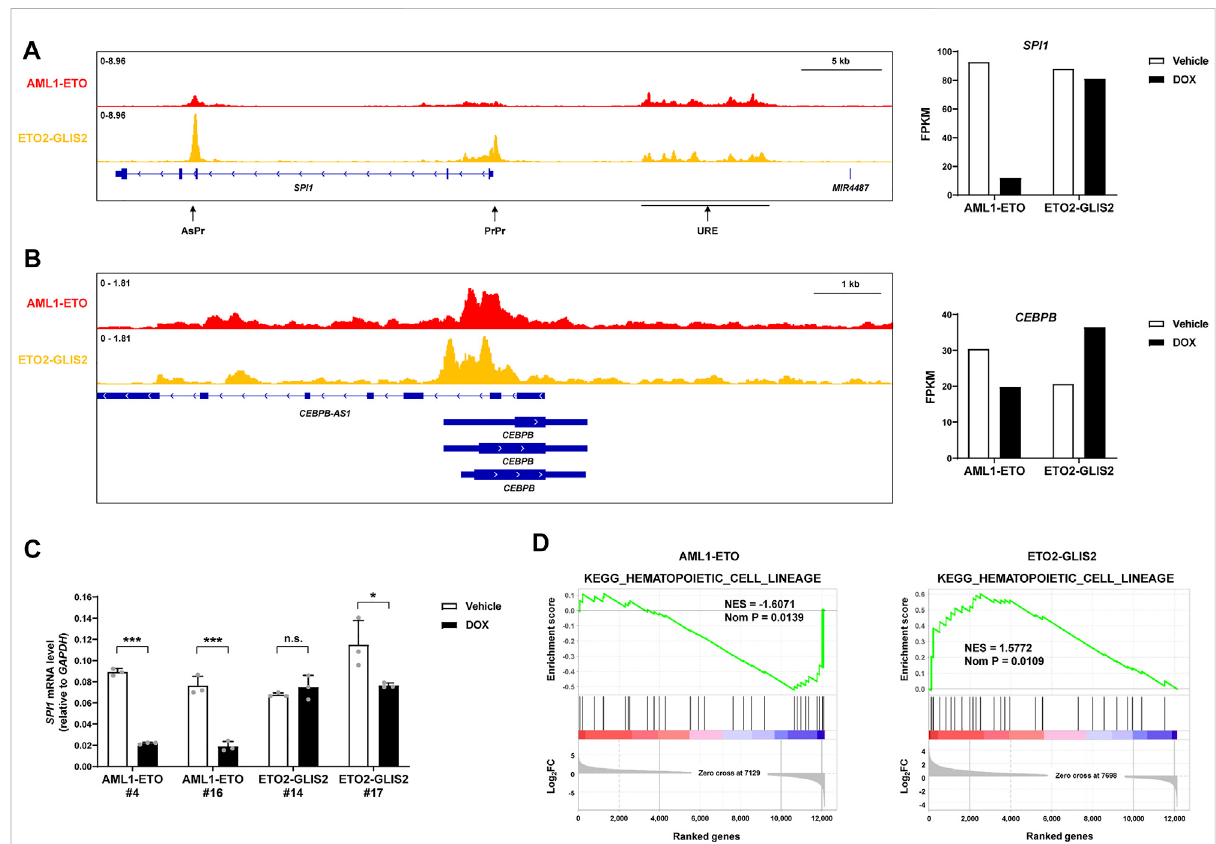
AML1-ETO and ETO2-GLIS2 differentially regulates key transcription factors that are important for myeloid differentiation. (A) SPI1 (encoding PU.1) is repressed by AML1-ETO, but not ETO2-GLIS2. Three important regulatory elements of SPI1 , the antisense promoter (AsPr), the proximal promoter (PrPr), and the upstream regulatory element (URE), are denoted with arrows. Note that AML1-ETO and ETO2-GLIS2 bind to URE at similar levels, whereas the levels of their binding to PrPr and AsPr are clearly different. (B) CEBPB (encoding C/EBP β ) is downregulated by AML1-ETO but upregulated by ETO2-GLIS2. (C) RT-qPCR analysis of the regulated expression of SPI1 in independent clone of the cell lines expressing AML1- ETO ( # 4 and # 16) and ETO2-GLIS2 ( # 14 and # 17). Data are presented as means ± SD of three separate experiments; two-tailed t -test; *** p <